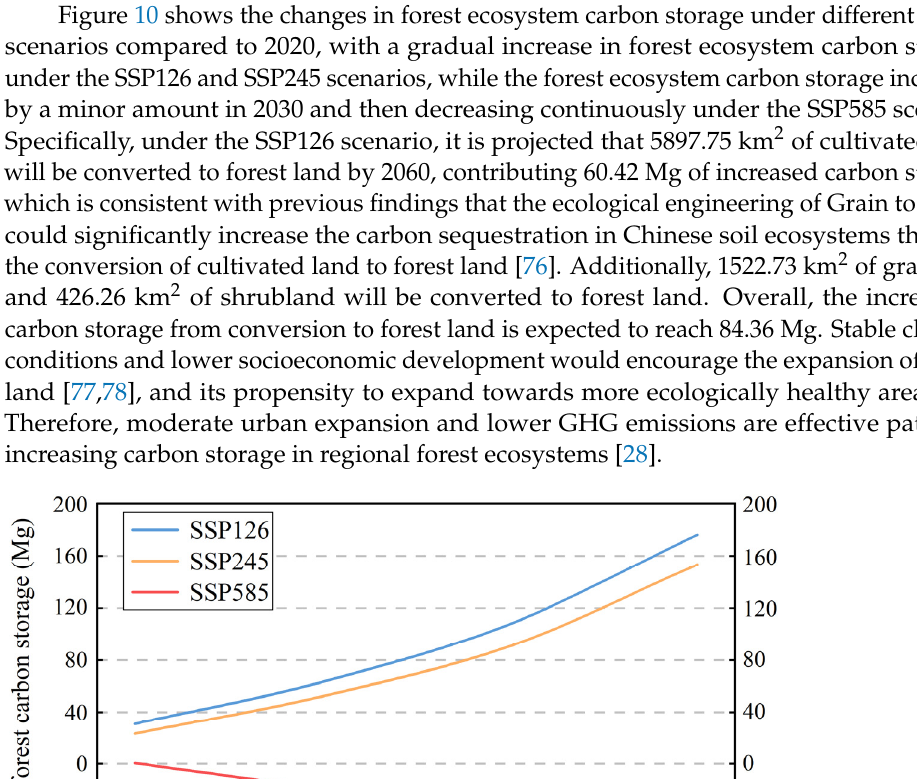
forest ecosystems. 4.3. Suggestions for Future Development In the context of increased future climate and socioeconomic uncertainties, ecological environments are becoming increasingly fragile and natural vegetation land use types such as forest land are continuously degraded [28], which has resulted in a decrease in carbon storage in the study area. Therefore, it is particularly important for policy makers to formulate and implement policies related to socio-economic development and land use planning in order to optimize the land use structure and increase carbon storage. The results of this study indicate that rapid economic growth will lead to a continu- ous decrease in ecosystem carbon storage and degradation of the ecological environment. Therefore, slowing down the rate of economic growth and reasonably planning urban development could improve the value of ecosystem services in the study area. Reducing the use of fossil fuels and increasing the proportion of clean energy use will not only mit- igate the effects of climate change, but also prevent further degradation of forest land and grassland. In addition, various stakeholders should pursue the acceleration of the con- struction of provincial key public welfare forests, ecological demonstration villages, and demonstration rural road forestry networks, and programs to nurture unestablished for- est land, replanting and replenishing them to encourage them to become forest land as